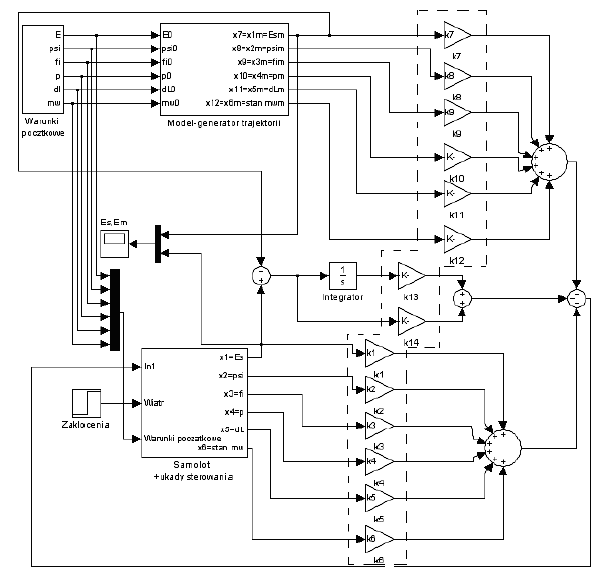
Fig 7b. Simulation results with the use of model-following control-